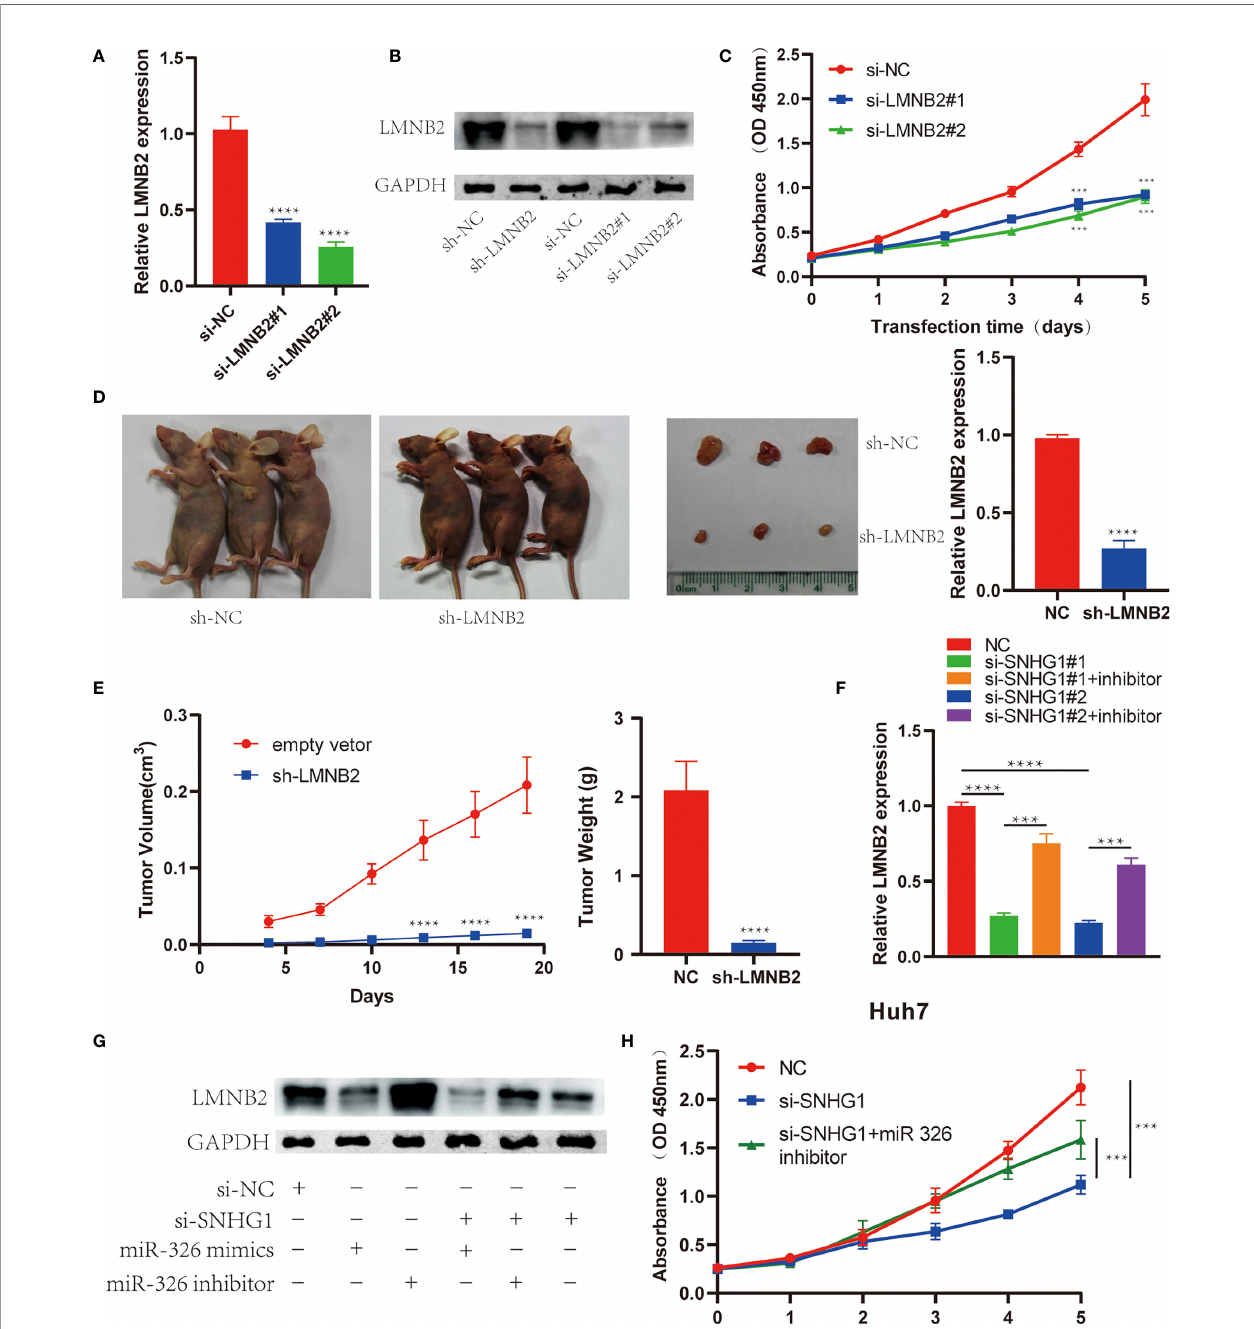
FIGURE 8 | LMNB2 promotes hepatocellular carcinoma (HCC) growth and mediates the role of SNHG1 in HCC. (A) LMNB2 expression decreased signi fi cantly in Huh7 cells with LMNB2 siRNA treatment (****p < 0.0001). (B) Western blotting was performed to detect the protein level of LMNB2 in Huh7 cells. (C) OD value of Huh7 cells with LMNB2 knockdown and control cells in the 3-(4,5-Dimethylthiazol-2-yl)-2,5-diphenyltetrazolium bromide (MTT) assay (***p < 0.0001). (D, E) Quanti fi cation of tumor volume and tumor weight of mice following the injection of HuH7 cells with LMNB2 knockdown or control cells. Representative images of mice bearing tumors, and tumor images were shown (****p < 0.0001). (F) The qRT-PCR demonstrated that miR-326 inhibitor rescued the decreased LMNB2 expression caused by SNHG1 knockdown (***p < 0.001, ****p < 0.0001). (G) Western blotting assay showed that miR-326 regulated LMNB2 expression, and miR-326 inhibitor rescued LMNB2 downregulation caused by SNHG1 knockdown in Huh7 cells. (H) MTT assays demonstrated that miR-326 inhibitor rescued tumor growth inhibition caused by SNHG1 knockdown (***p <